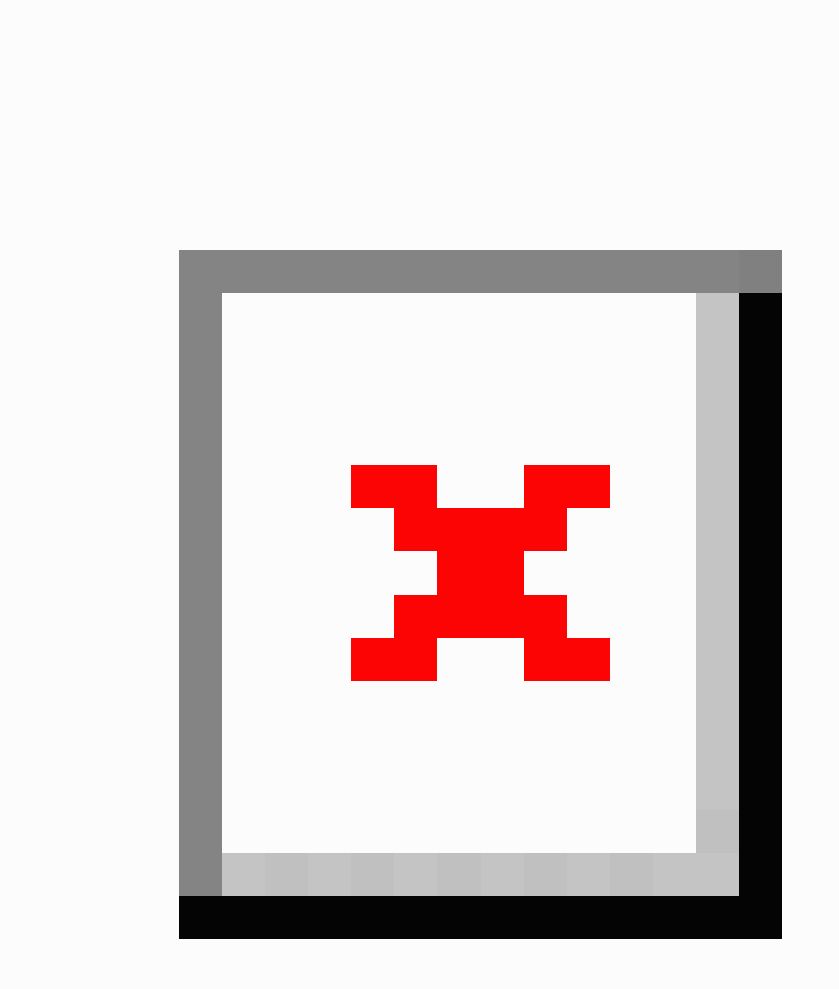
Figure 1. PRISMA (Preferred Reporting Items for Systematic Reviews and Meta-Analyses) flowchart of app review process.